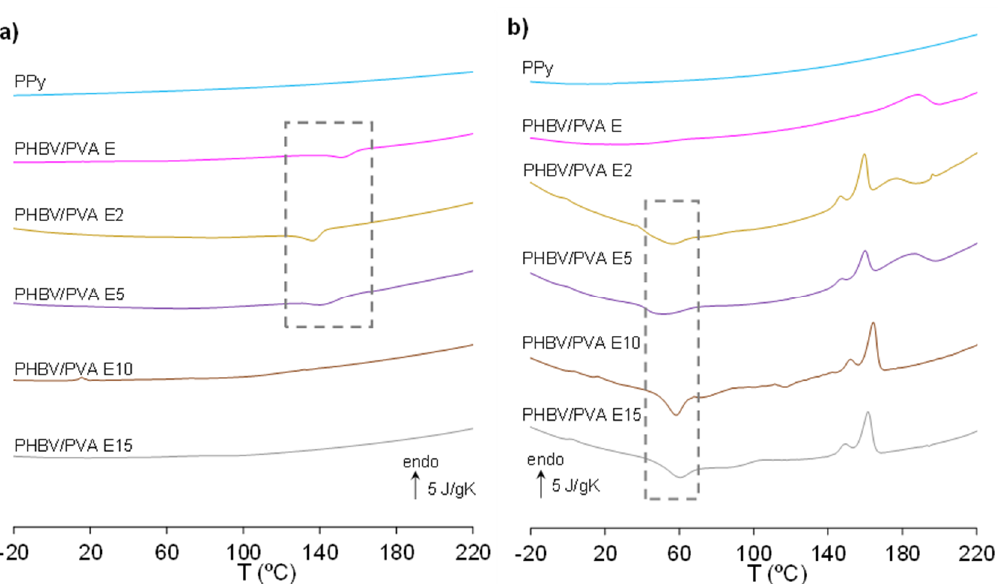
Figure 7. DSC thermograms at a rate of 20 °C/min of PHBV/PVA E with different percentages of PPy nanoparticles ranging from 0 to 15 wt/wt %. ( a ) Normalized heat flow on cooling and ( b ) normalized heat flow on heating. Rectangles mark endo and exotherm crystallization peaks.